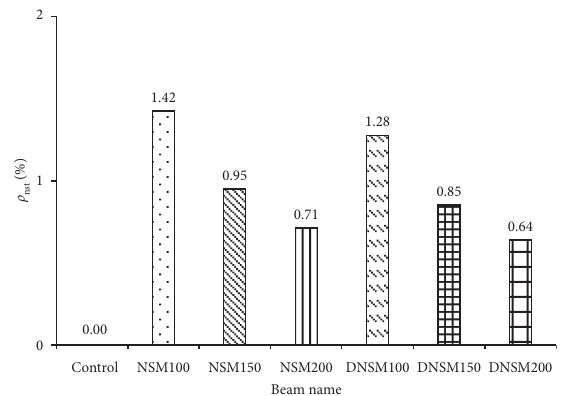
Figure 8: NSM steel reinforcement ratios for the strengthened beams.